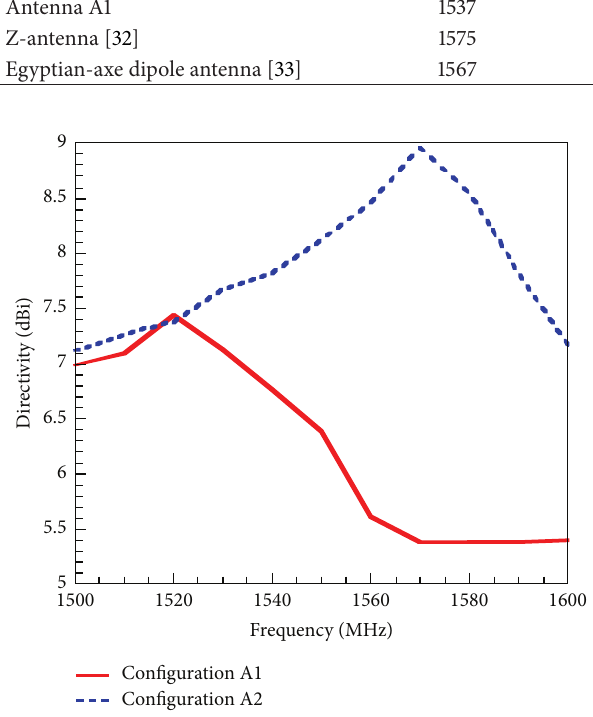
Figure 13: Measured directivity of the studied antenna with cou- pling distance 𝑑 1 : (a) configuration A1 ( 𝑑 1 = 4 mm), (b) configura- tion A2 ( 𝑑 1 =